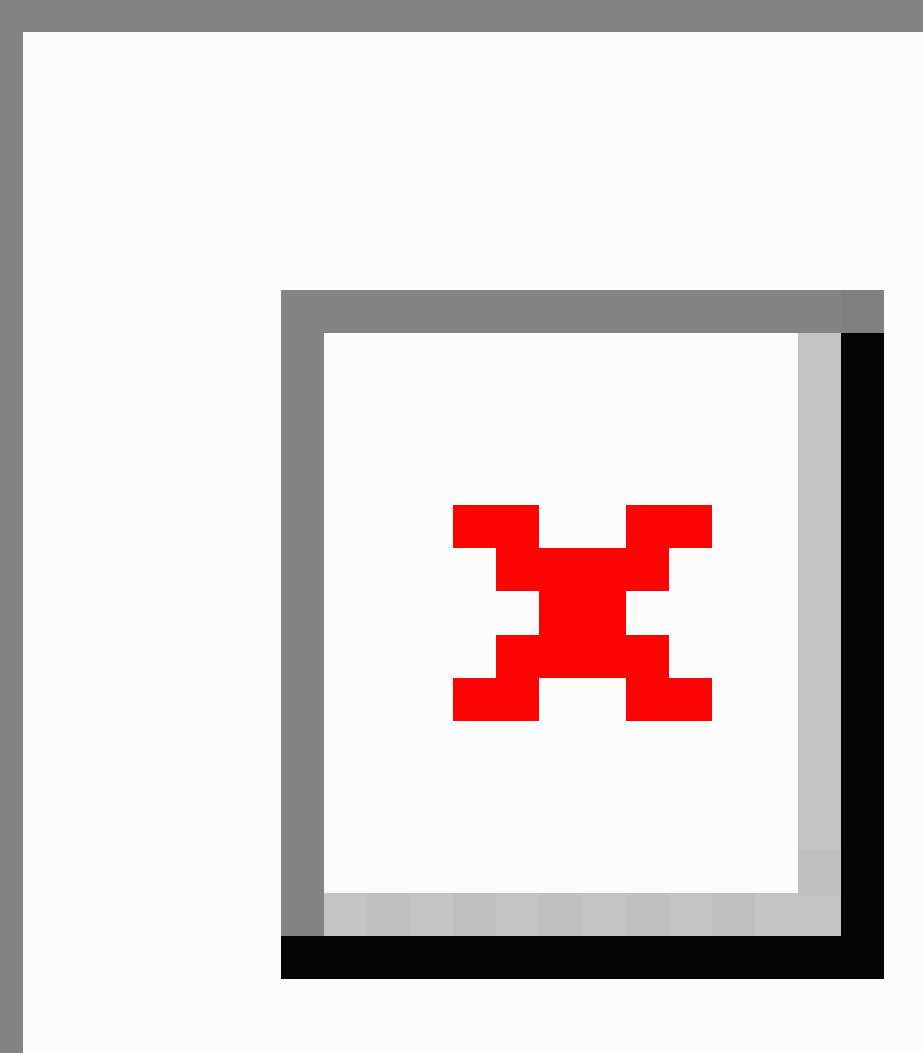
Figure 1. Flowchart of the colorectal cancer patient